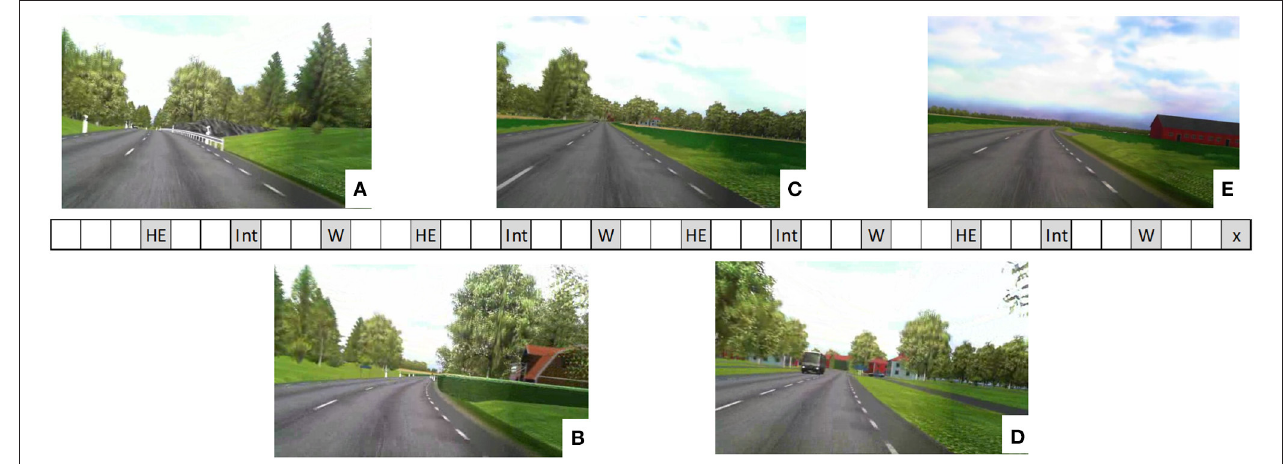
FIGURE 1 | Illustration of the experimental drive. The rectangle in the middle of the figure represents the sequence of events. Each square is ∼ 1min of driving (depending on vehicle speed). Measurement scenarios are colored in gray. HE, Hidden Exit; Int, Intersection; W, Wind. The final scenario, x, was an unexpected lead vehicle braking scenario which is not included in this study (but see Nilsson et al., 2018). The five images show scenery examples from one of the positions where the hidden exit warning sign became visible for the driver (A) ; the hidden exit became visible (B) ; 500m before the 4-way intersection (C) ; 80m before the 4-way intersection (D) ; and the open field in the Wind scenario (E) . Images are blurry due to poor camera resolution, but the participants experienced them in high resolution in the driving simulator.